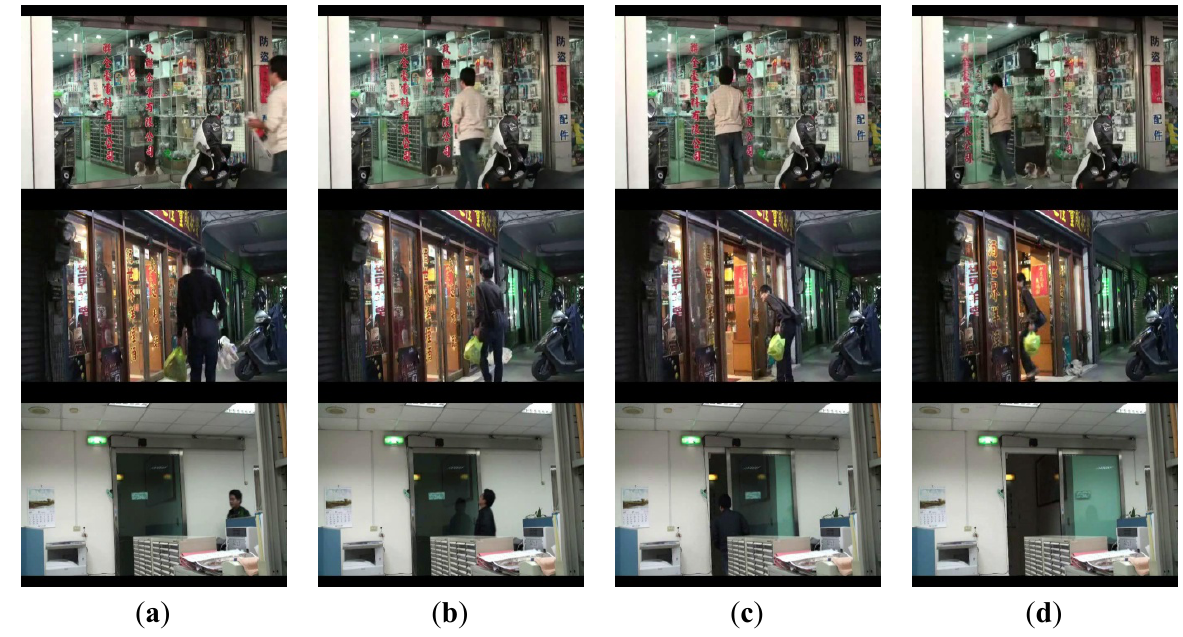
Figure 9. Illustrations of success door activation by person with accessing intention at 3 business places. The first row: electronic materials store (day). The second row: wine store (night). The third row: business office